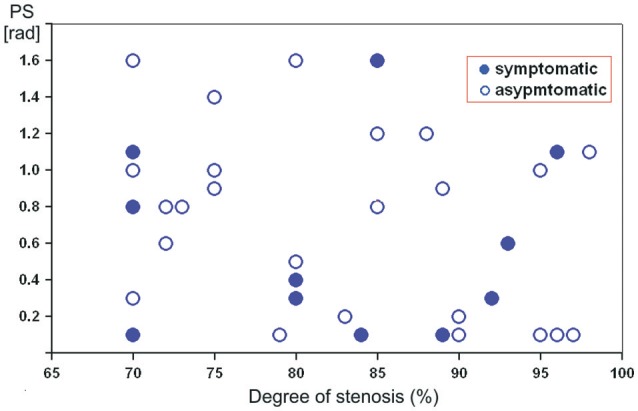
Scatterplot showing the relation between preoperative phase shift values (in radians) on the affected side and the degree of severe internal carotid artery stenosis in asymptomatic and symptomatic patients.